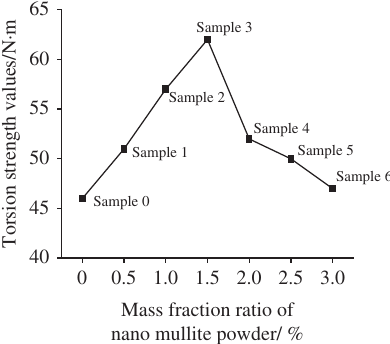
Figure 2 Comparative torsion strength value of the GFRP-anchor body as a function of nano mullite powder